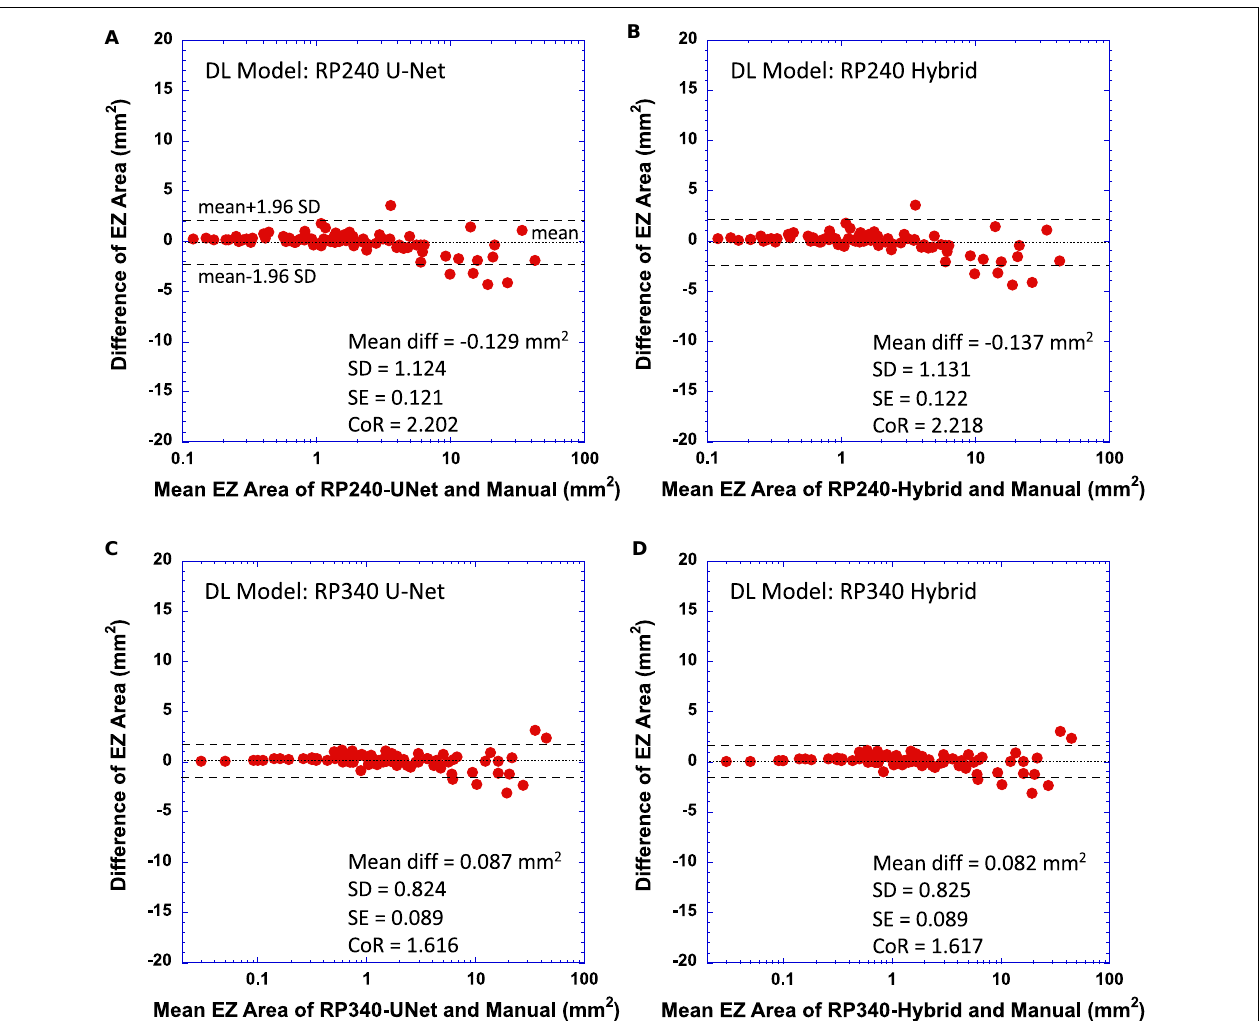
FIGURE 4 | Bland-Altman plots of difference of measurements between deep learning (DL) models and the reading center vs. their mean. (A) RP240 U-Net vs. manual grading; (B) RP240 hybrid model vs. manual grading; (C) RP340 U-Net vs. manual grading; and (D) RP340 hybrid model vs. manual grading. Coefficient of repeatability (CoR) is defined as 1.96 times the standard deviation of the difference. Dashed horizontal lines represent ± 95% limit of agreement (mean ± CoR). Dotted horizontal lines represent the mean